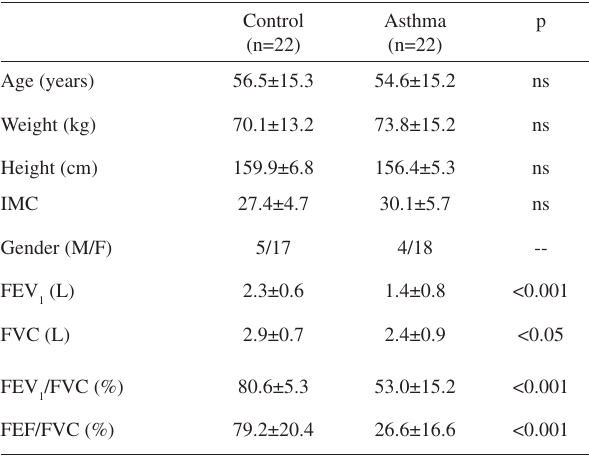
Table 2 - Pearson correlation coefficient (r), coefficient of de- termination (r 2 ), and p-value (p) between FOT and spirometry.